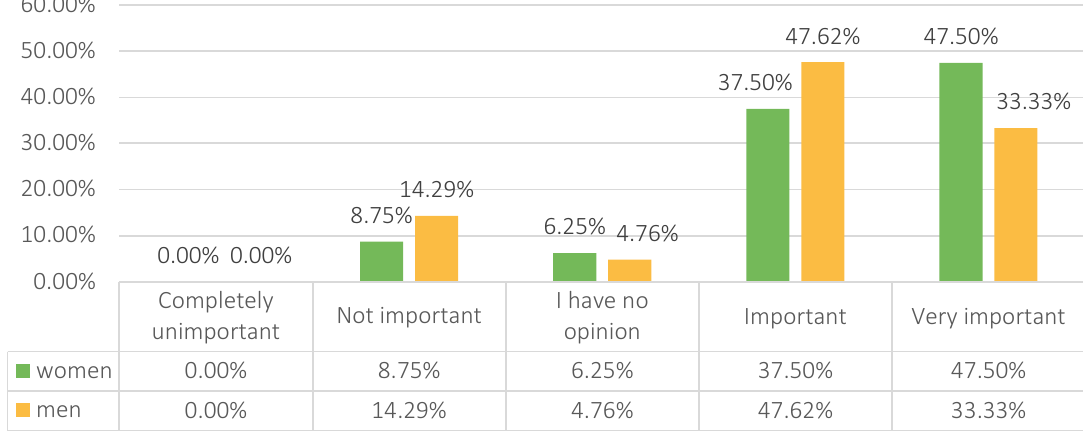
Figure 3. Importance of integrity for supervisors during the COVID-19 crisis (by gender of